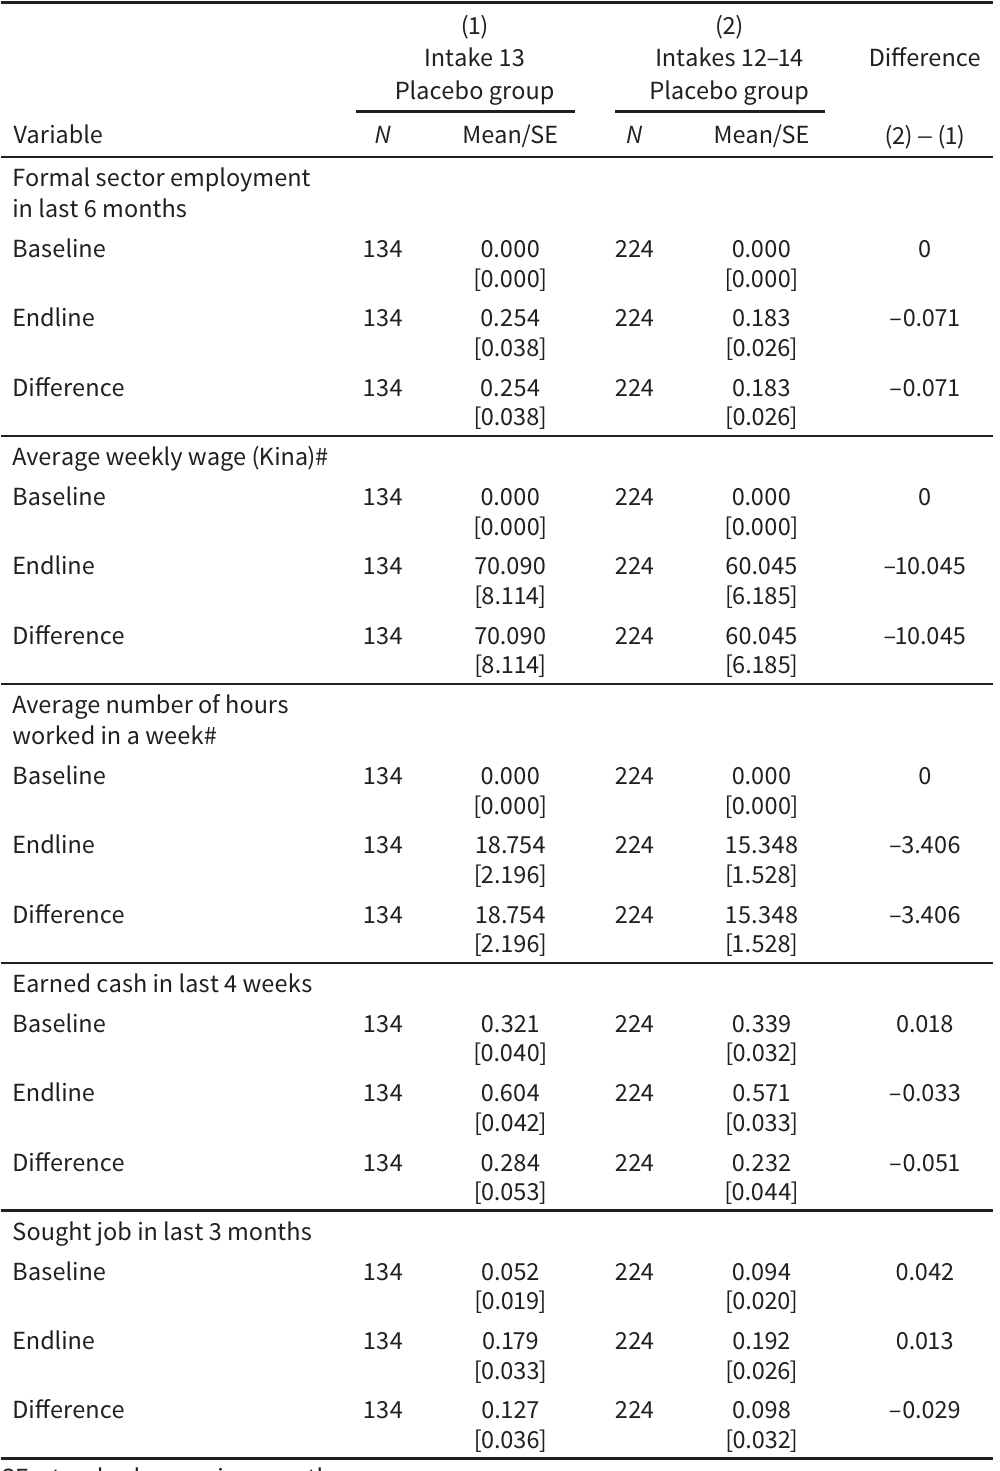
Results of the placebo test of the equal trends